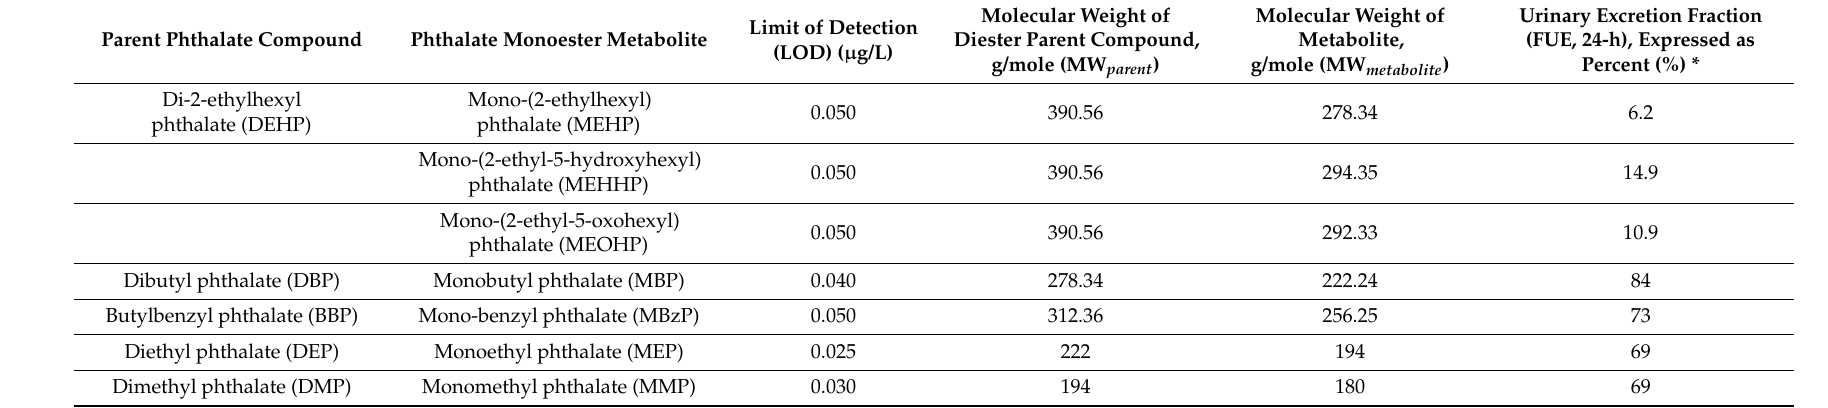
Table 1. Molecular weights and urinary excretion fractions for phthalate